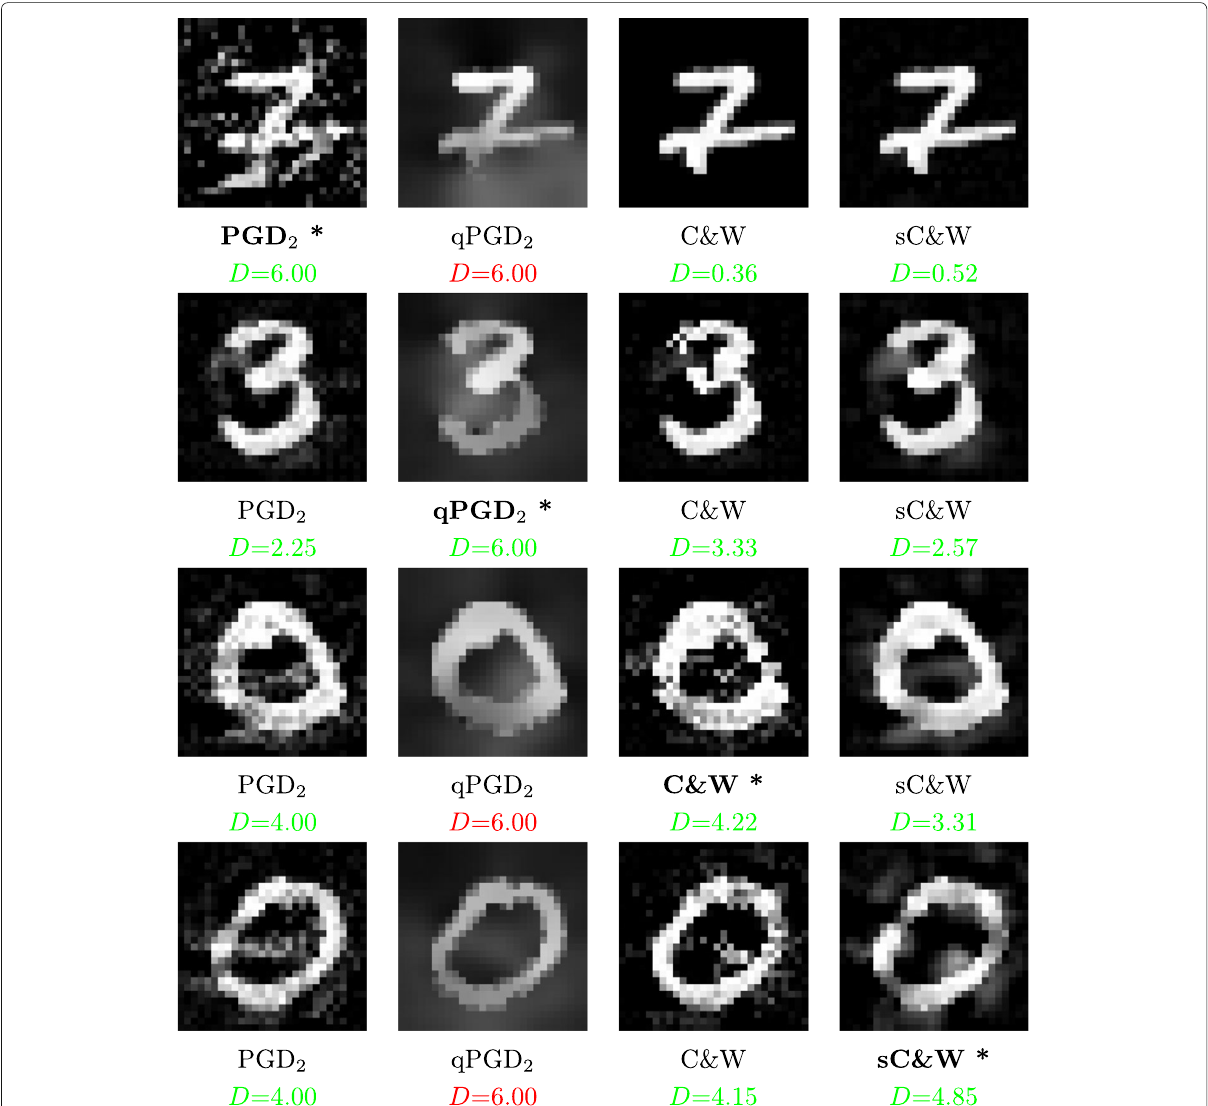
Fig. 2 For a given attack (denoted by an asterisk and bold typeface), the adversarial image with the strongest distortion D over MNIST. In green, the attack succeeds; in red, it